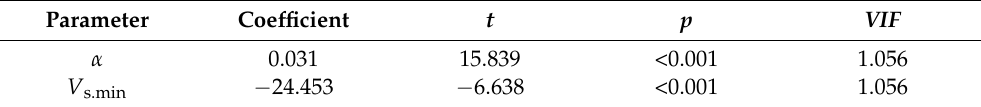
Table 2. The coefficients, t -test ( t value), significance level ( p value) and variance inflation factor ( VIF value) of each descriptor in the MLR